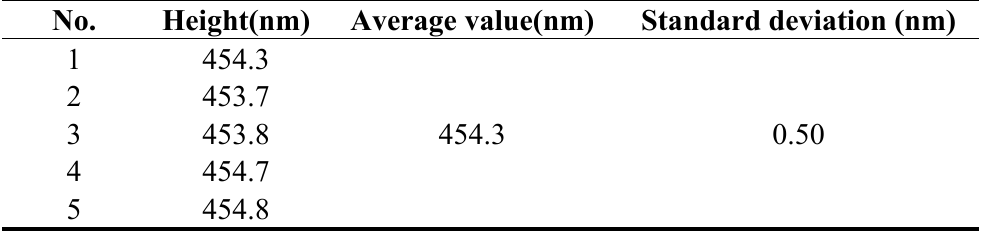
Table 1. The evaluation results of 450 nm step height